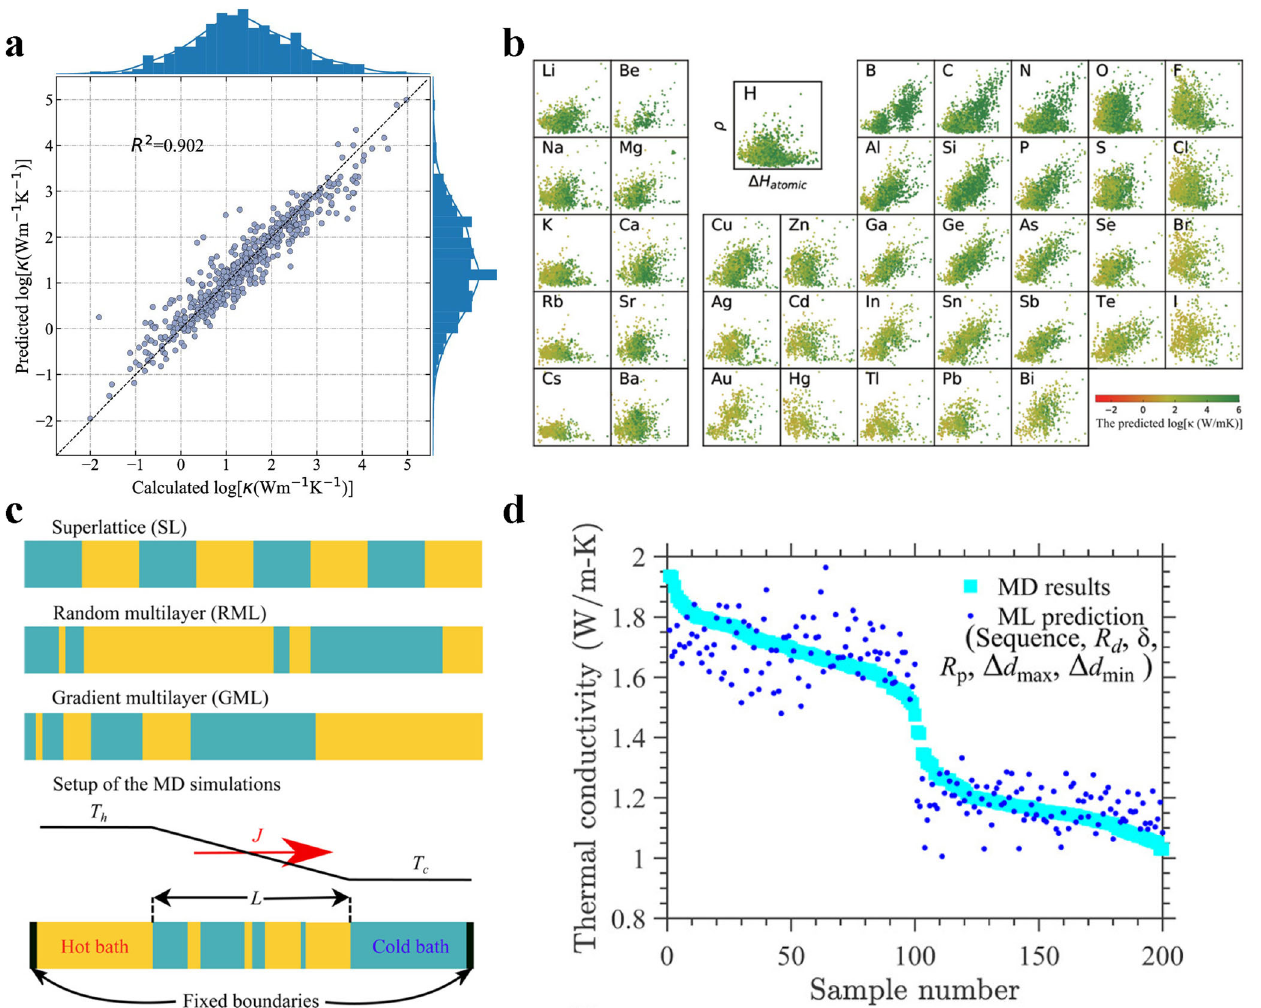
Fig. 2 High-throughput prediction of lattice thermal conductivities by machine learning models. a The XGBoost model-predicted log- scaled κ L versus the calculated values for the testing set. The top and right histograms show the corresponding data distributions. b Dependence of the predicted κ L on speci fi c elements for compounds in the ICSD, and the values are shown by colors along with the ρ . a and b are reproduced with permission from ref. 44 . c Schematics of the multilayer structures and the MD simulation setup. Δ H atomic and d Comparisons of the real and predicted κ L for 100 randomly generated RMLs and their corresponding 100 GMLs in the testing set. c and d are reproduced with permission from ref. 45